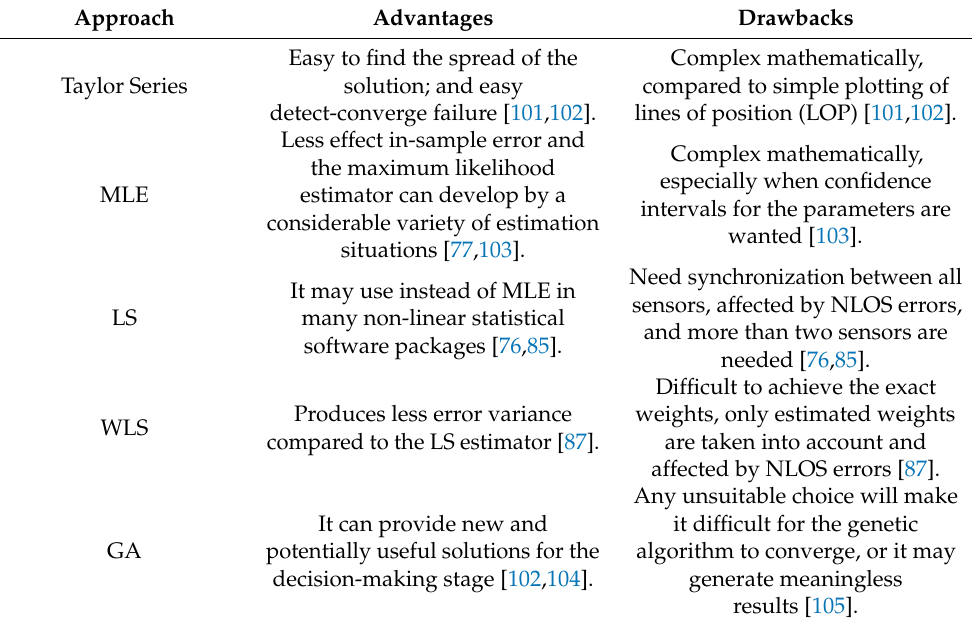
Table 3. Comparison between several approaches of optimizing geolocation and target tracking.